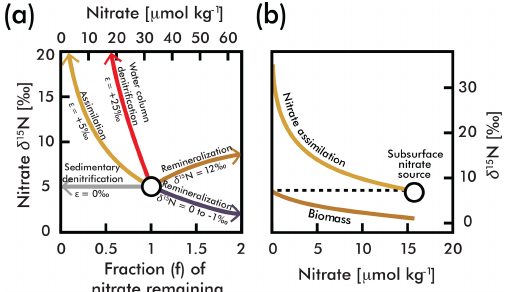
Figure 1. (a) A comparison of influences on average deep-sea ni- trate (circle; concentration and δ 15 N estimated here by EANN re- sults in Table 1) including the isotope effects of assimilation (yel- low arrow), water column and sedimentary denitrification (red and gray arrows), and the addition of nitrate via remineralization of or- ganic matter with higher and lower δ 15 N (brown and purple arrows) (modified from Galbraith et al., 2008). (b) An example of N isotopic fractionation during nitrate assimilation on nitrate and organic mat- ter biomass in eastern equatorial Pacific surface waters (from Rafter and Sigman, 2016). These calculations are based on isotopic frac- tionation equations of Mariotti et al., (1981) simplified in Sigman and Casciotti (2001) with an isotope effect ( ε ) as shown in (a) . The variable f is the initial nitrate concentration.